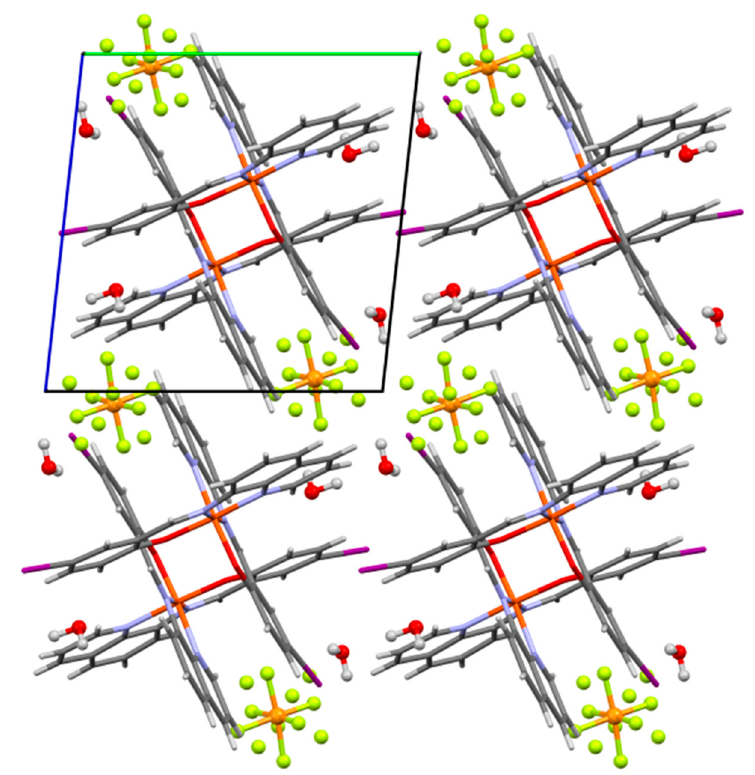
Figure 7. Crystal structure of 5.PF 6 .1.5H 2 O along the a